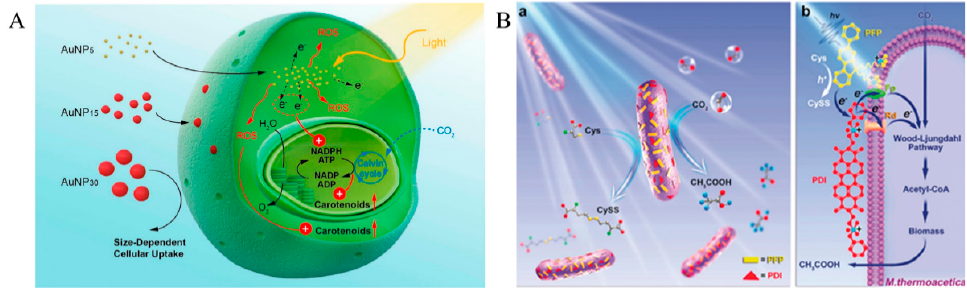
Figure 4. ( A ) C. zofingiensis -AuNPs hybrid system, where AuNPs significantly increase the relative electron transport rate in photosystem II, and the ROS level in microalgae (Copyright © 2020, Amer-